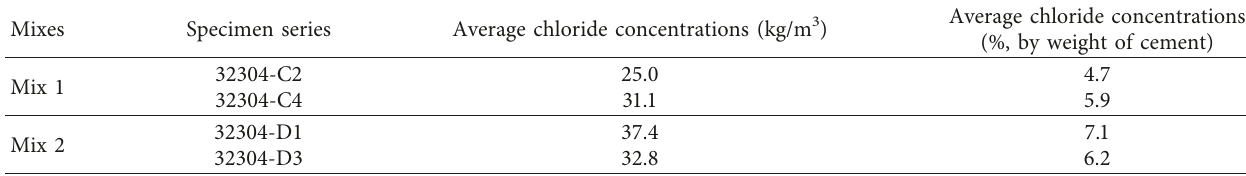
Table 4: Chloride concentration at rebar trace.